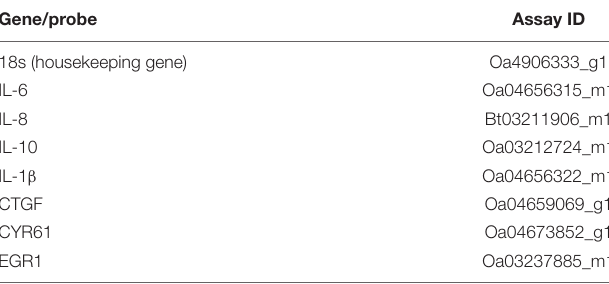
TABLE 1 | List of ovine specific probes for TaqMan Gene Array.